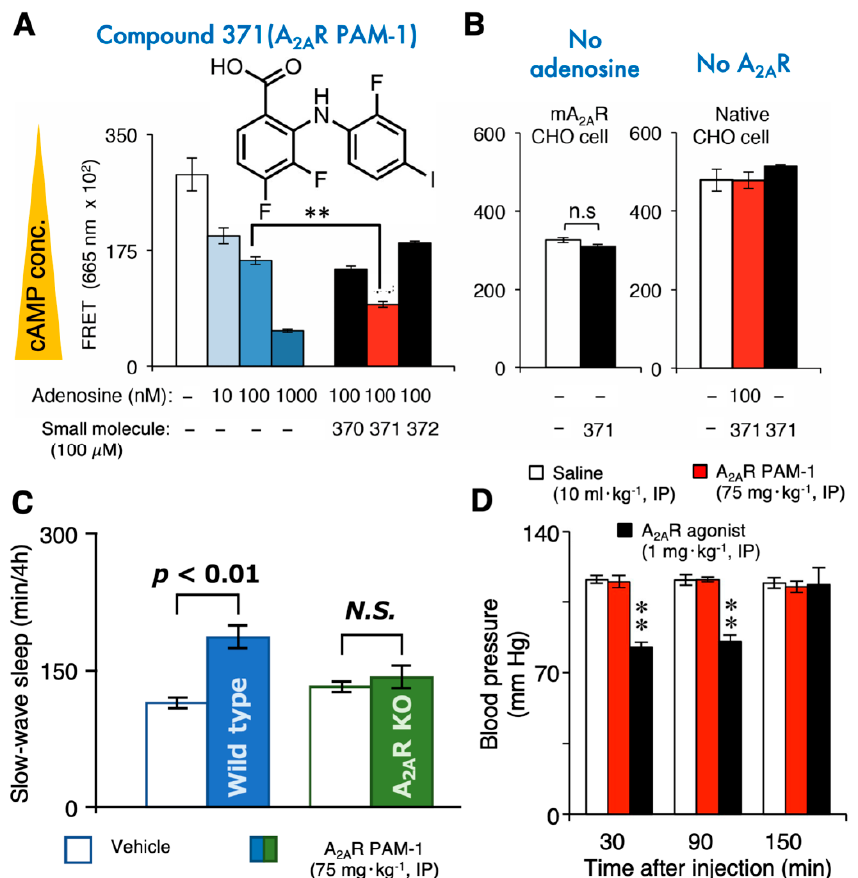
Figure 3. The A 2A R positive allosteric modulator (PAM)-1 induces sleep without cardiovascular effects. ( A , B ) A 2A R PAM-1 enhanced the activity of adenosine on A 2A R-expressing Chinese Hamster Ovary (CHO) cells when cAMP was measured by a fluorescence energy transfer (FRET) immunoassay ( A ), whereas A 2A R PAM-1 did not enhance cAMP production without adenosine or in native CHO cells without A 2A R expression ( B ). ( C ) Intraperitoneal (IP) injection of A 2A R PAM-1 increased slow-wave sleep in wild-type mice, but not in A 2A R-knockout (KO) mice. ( D ) A 2A R PAM-1 did not affect cardiovascular functions (e.g., blood pressure), unlike a classic A 2A R agonist (CGS 21680) [94,95]. ** p < 0.01.